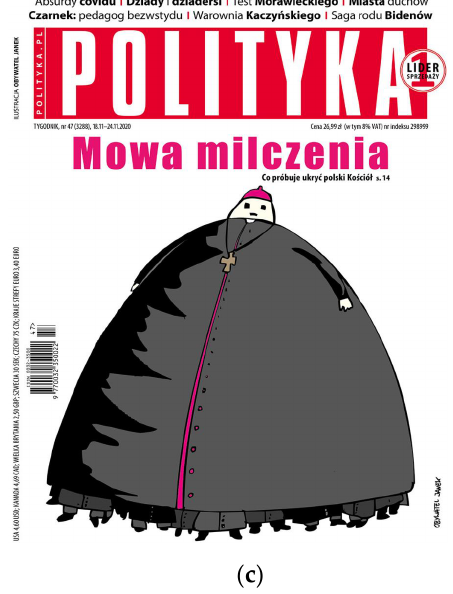
Figure 3. Selected covers interpreting Theme 2 (sexual abuse and paedophilia among the clergy) and Theme 3 (the consequences of the crisis within the Catholic Church). ( a ) Tygodnik Powszechny